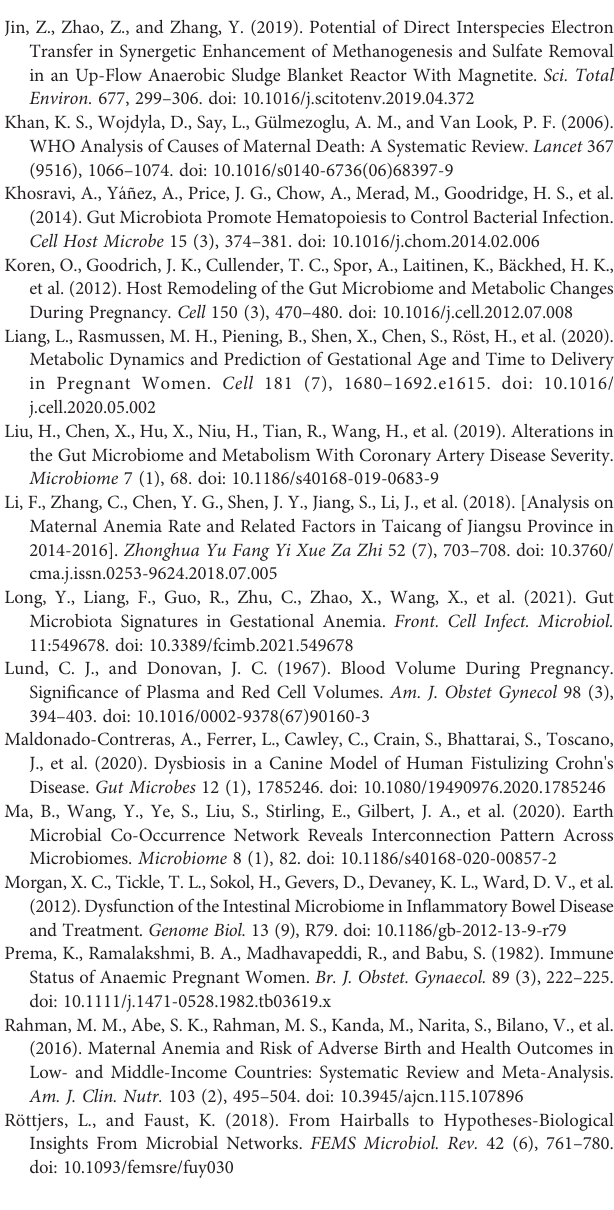
Supplementary Figure 1 | Flow chart of the inclusion of subjects.